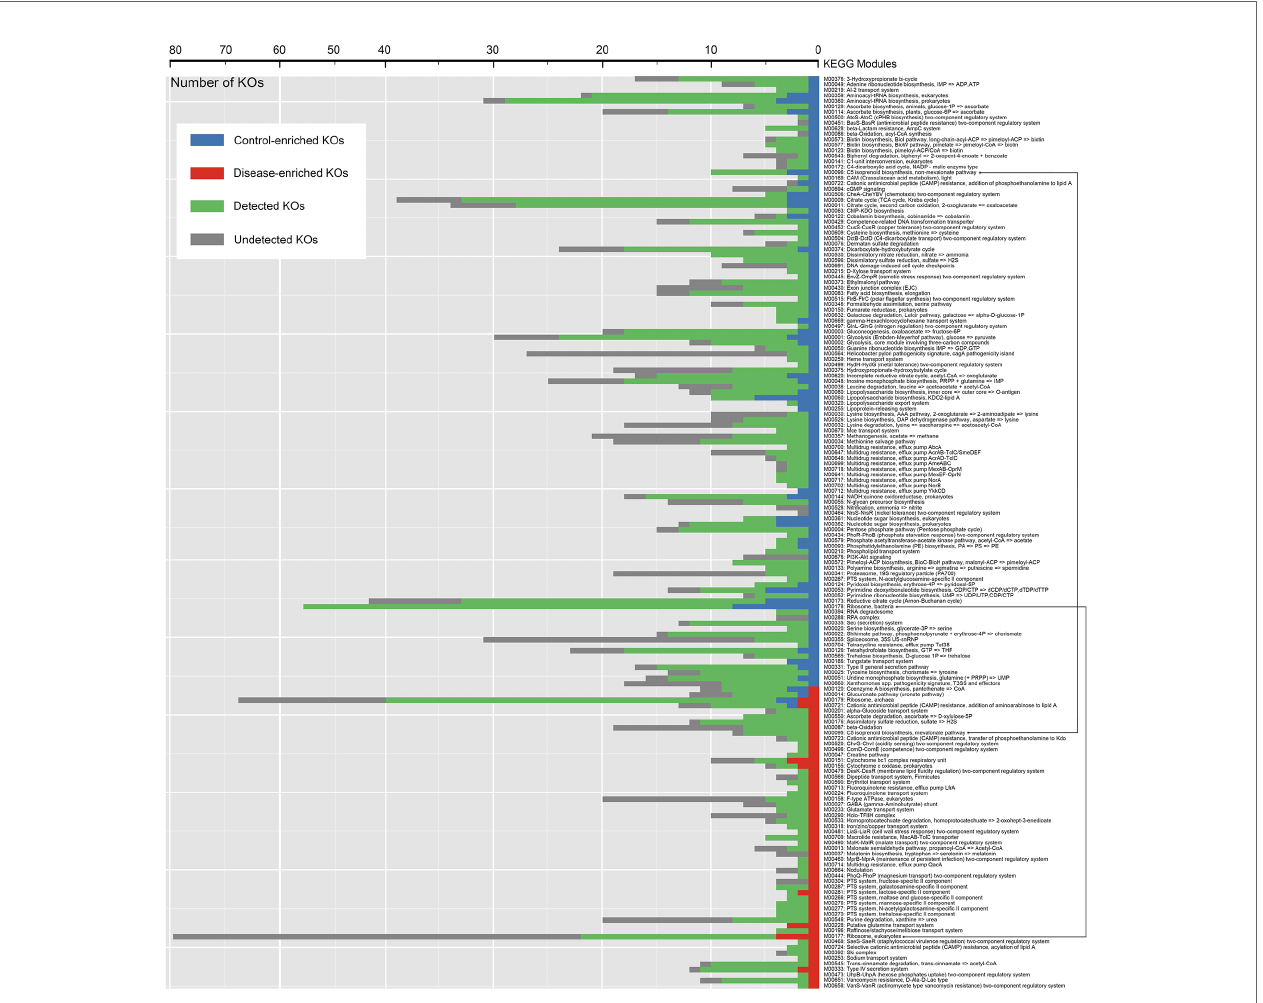
FIGURE 5 | Distribution of KEGG modules for HC-enriched and DIS-enriched KEGG orthologues (KOs). Each bar represents the number of KOs involved in each module. Green bars represent KOs detected in salivary samples to the extent of our sequencing. Blue and red bars represent KOs that were differentially detected in samples from healthy controls and patients with chronic erythematous